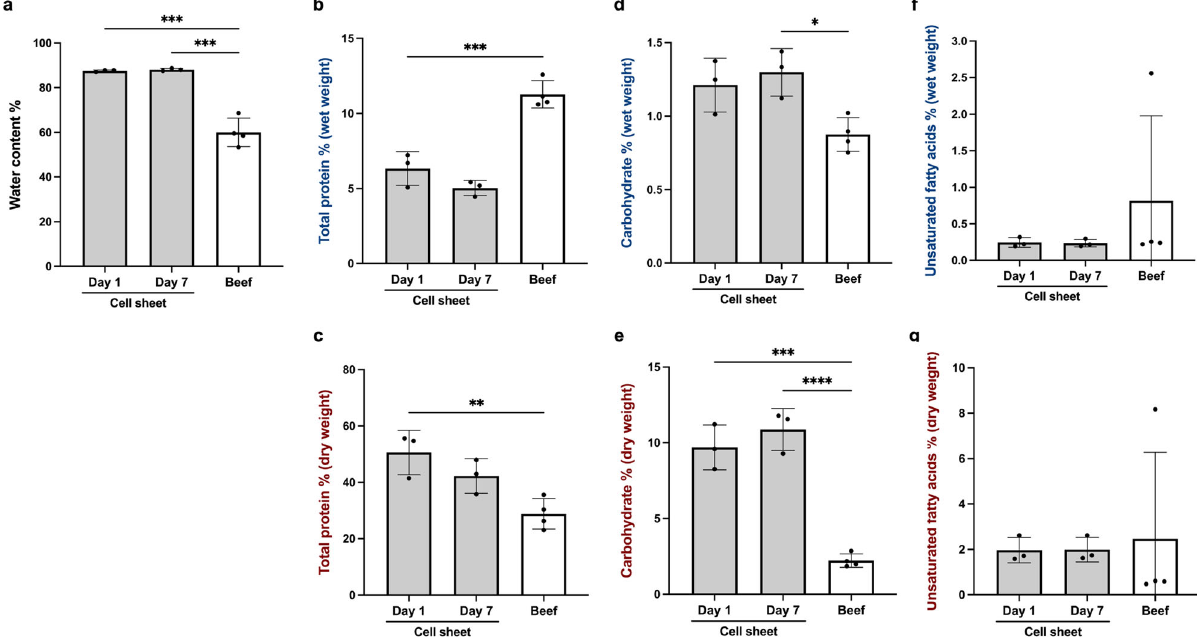
Fig. 5 Nutritional analysis of cell sheets and beef. a Water content of cell sheets and beef. b Total protein in wet weight. c Total protein in dry weight. d Carbohydrate in wet weight. e Carbohydrate in dry weight. f Unsaturated fatty acids in wet weight. g Unsaturated fatty acids in dry weight. In ( b – g ), the data points represent individual values (Cell sheet: n = 3, Beef: n = 4), and the error bars represent SD. ** P < 0.01, *** P = 0.0001, **** P < 0.0001 was considered signi fi cant in the analysis between groups using one-way ANOVA, with Tukey ’ s